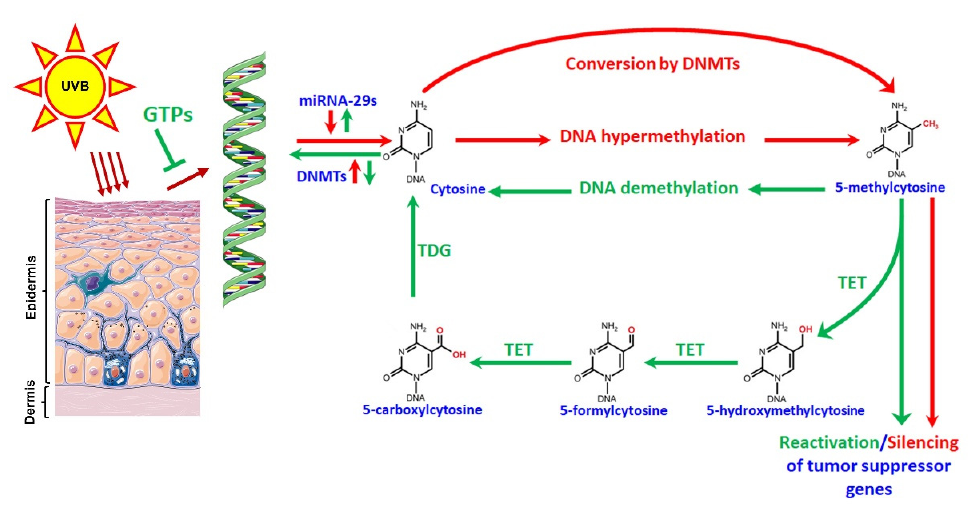
Figure 7. An illustration of the mechanism GTPs adopt to prevent photocarcinogenesis via targeting miR-29s-mediated DNA hypermethylation. Exposure to UVB radiation diminishes the expression levels of miR-29s and leads to activation of DNMTs and promotes DNA hypermethylation, resulting in the silencing of tumor suppressor genes and contributing to tumor growth. GTPs treatment blocks the UVB-induced damage and restores the expression of miR-29s to stop DNA hypermethylation through inhibition of DNMTs. As a parallel mechanism, GTPs treatment activates TET enzymes and converts existing 5mC into 5-hmC followed by 5fC and 5caC to promote DNA demethylation, which leads to growth inhibition by reactivation of silenced tumor suppressors. Red arrows indicate the UVB radiation-regulated pathway while green arrows show the GTPs-regulated pathway. DNMT, DNA methyltransferases; TET, ten-eleven-translocation; TDG, thymine DNA glycosylase. Parts of the figure were obtained from Servier Medical Arts, freely available at https://smart.servier.com.